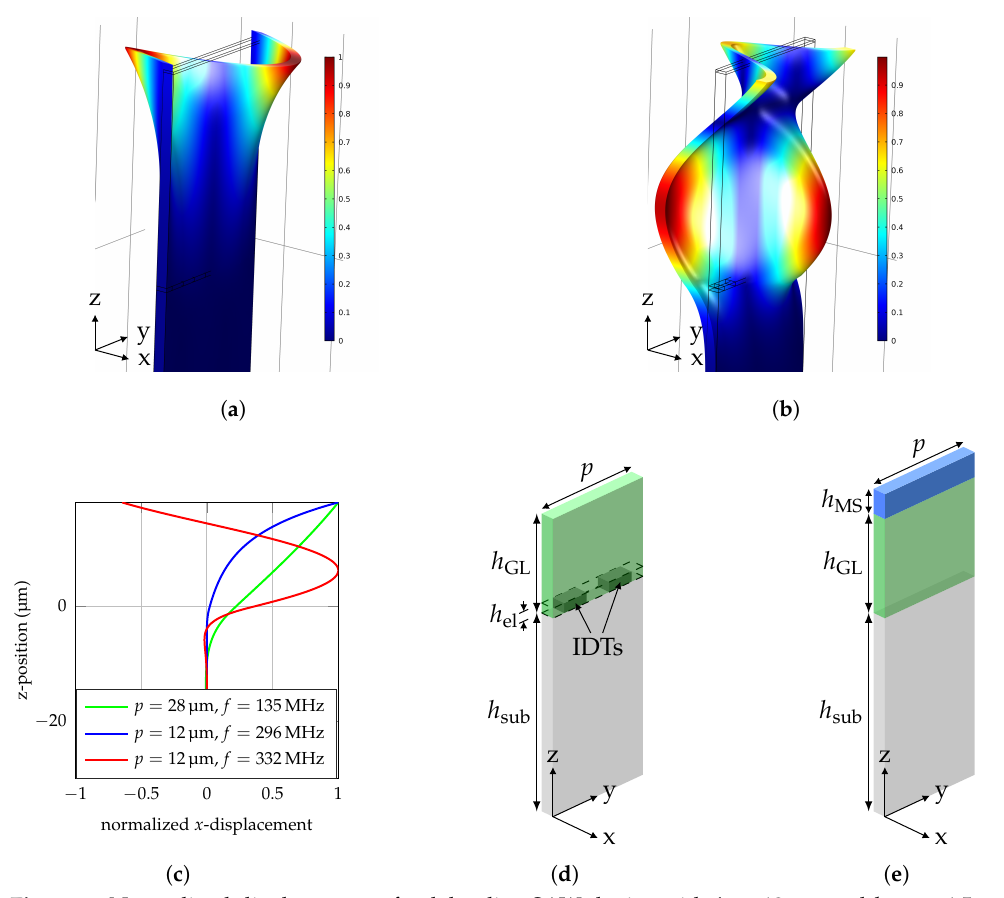
Figure 3. Normalized displacement of a delay-line SAW device with λ = 12µm and h GL = 4.5µm for the ( a ) 0th mode and ( b ) 1st mode calculated using a frequency domain study. ( c ) Mode profile of Love-waves at different wavelengths with a 500µm thick quartz substrate for z < 0 and a 18µm thick guiding layer above z = 0. Schematic simulation setup of the unit cell for the excitation region ( d ) and the delay-line region ( e ). With a width of p , substrate thickness h sub , guiding layer thickness h GL , electrode thickness h el , magnetostrictive layer thickness h MS and the interdigital transducers